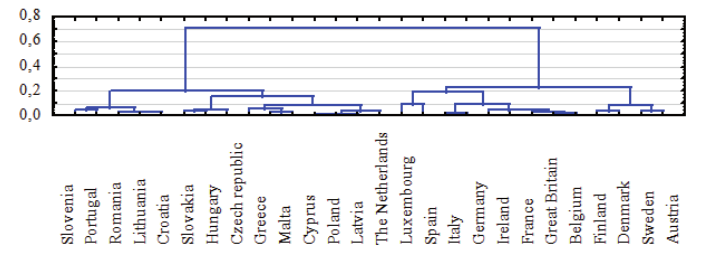
Fig.1 – Complete results of the cluster analysis of identified composite indicators of competitiveness (2017). Source: authors’